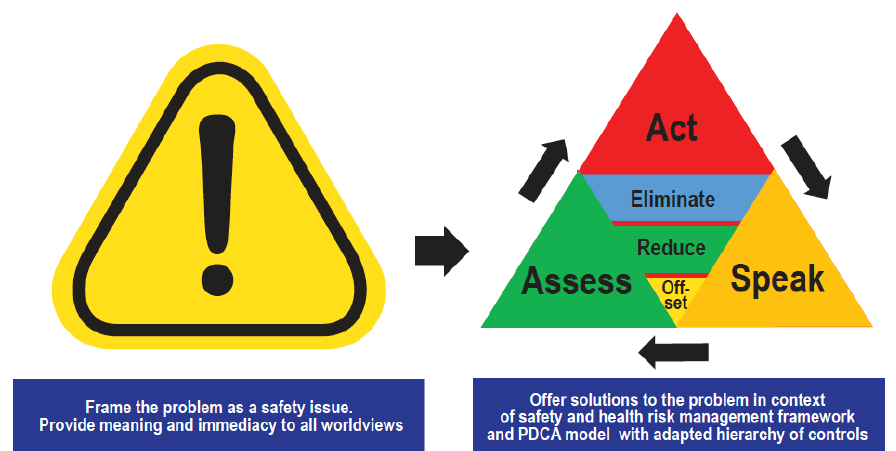
Figure 2. Climate Action Communication and Mitigation Strategy Through a Health and Safety Risk Management Framework .